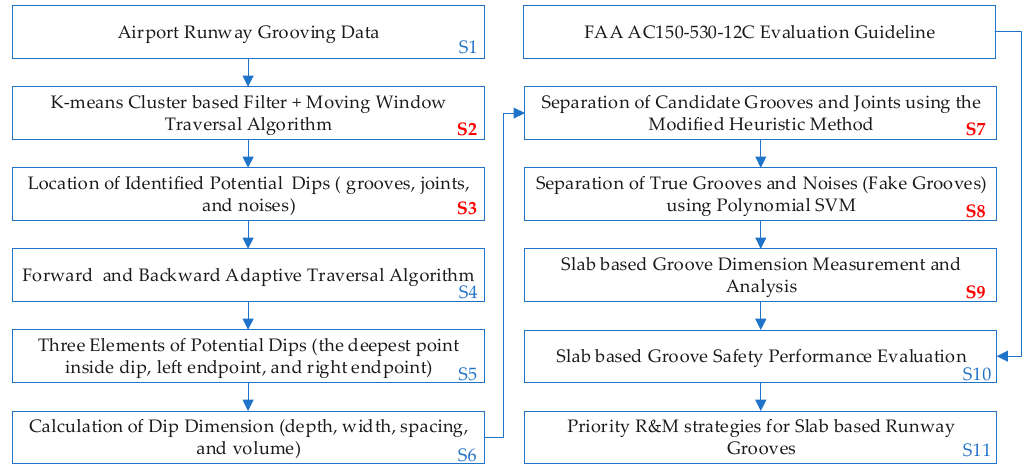
Figure 2. Schematic of the new methodology for concrete slab-based groove identification and performance evaluation.